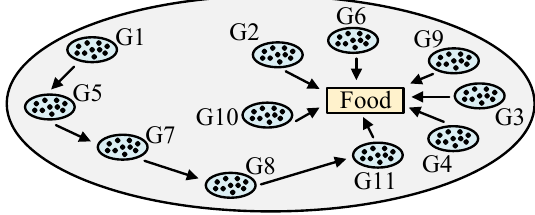
Figure 2. Schematic diagram of the SFLA algorithm.